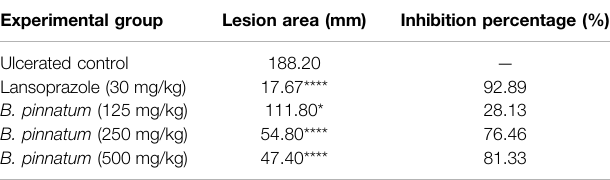
TABLE 2 | Effect of treatment with B. pinnatum leaf extract (125, 250, and 500 mg/kg) inthelesion areaand percent inhibition intheacetic acid – induced chronic gastric ulcer